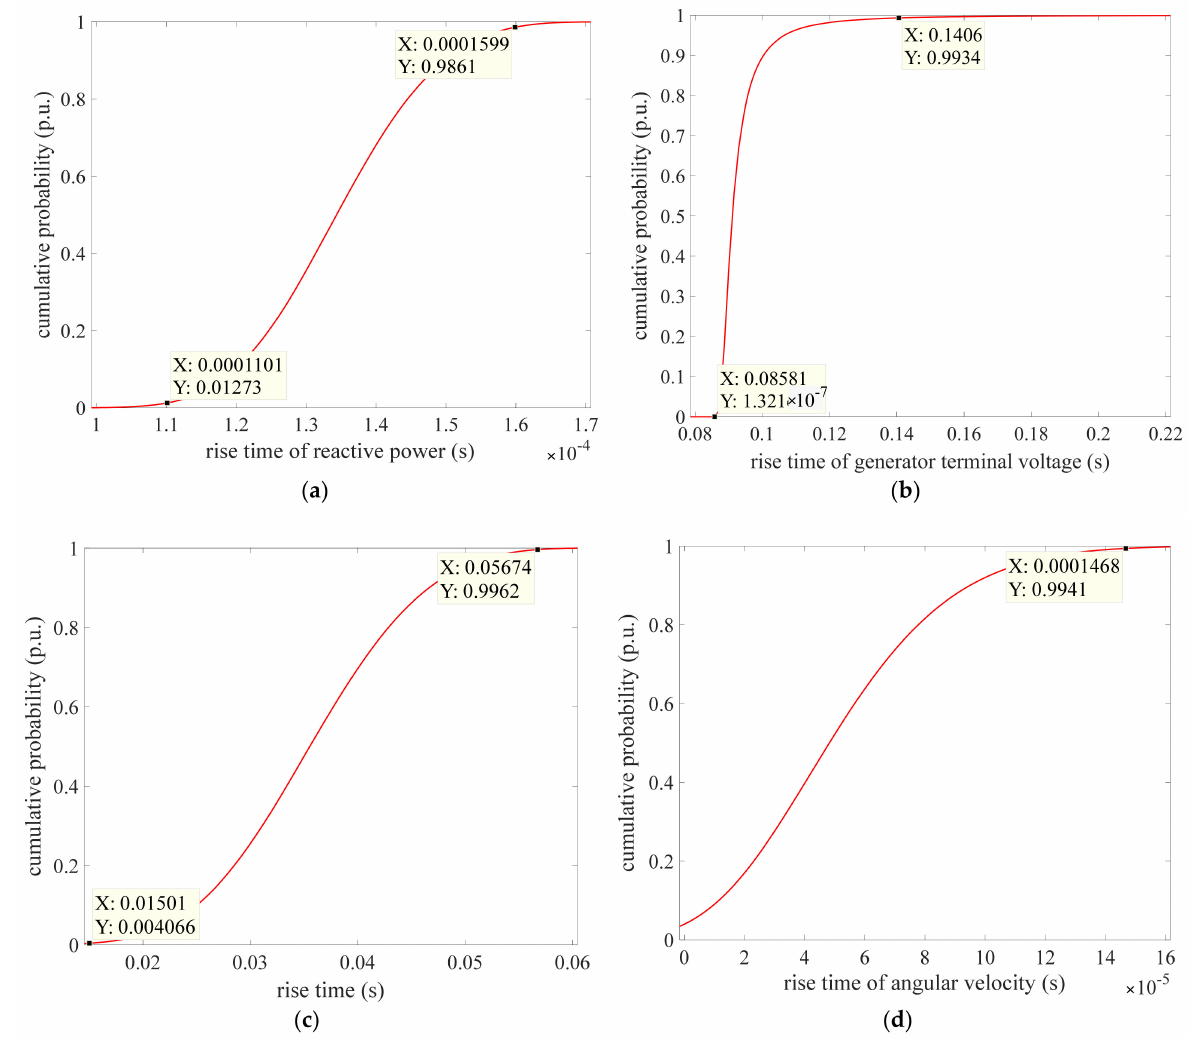
Figure 13. The cumulative probability of the rise time. ( a ) The cumulative probability of the rise time of the reactive power; ( b ) The cumulative probability of the rise time of the generator terminal voltage; ( c ) The cumulative probability of the rise time of the guide vane opening; ( d ) The cumulative probability of the rise time of the angular